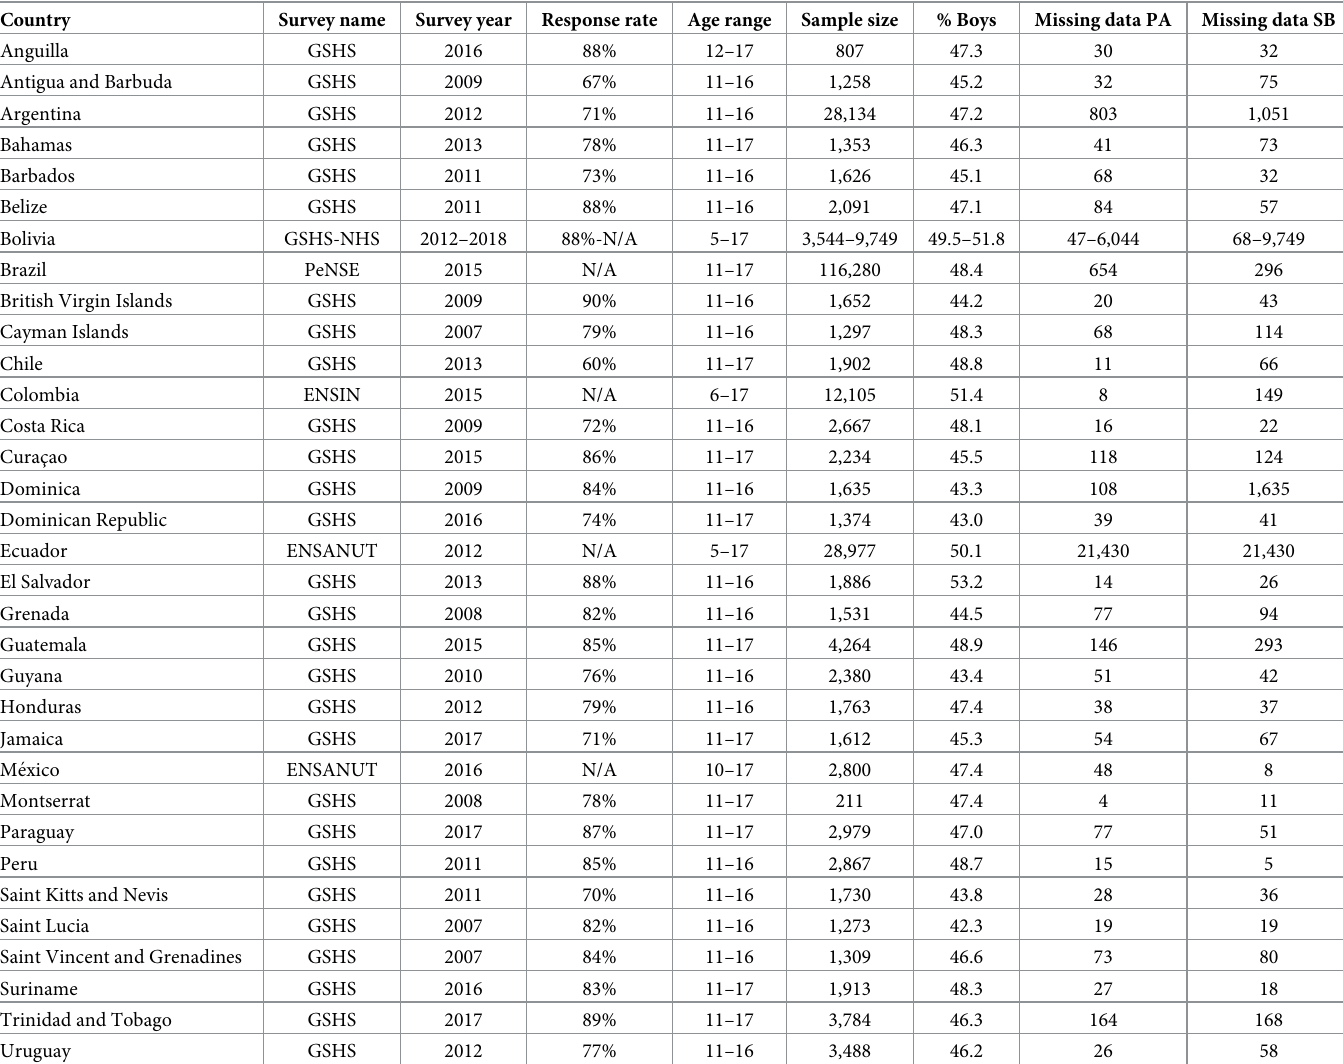
Table 2. Descriptive characteristics of the surveys included in the